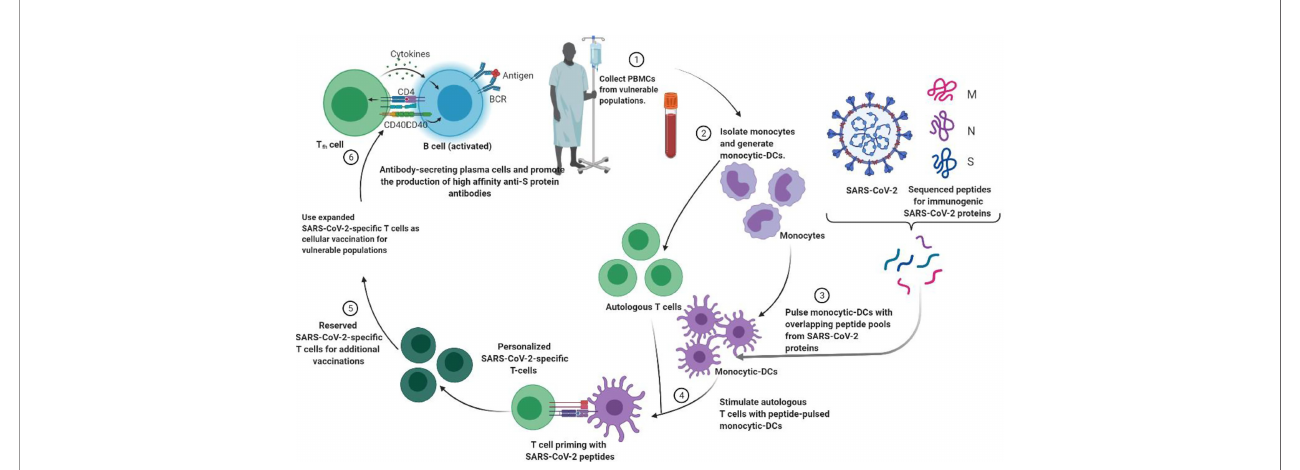
FIGURE 3 | Strategies to generate tailored virus-speci fi c T cells as potential therapeutics for prophylaxis and/or treatment of SARS-CoV-2 infection among vulnerable populations. Monocyte DCs from individuals are treated with SARS-CoV-2 peptide and then used to prime T cells from the same individual to generate